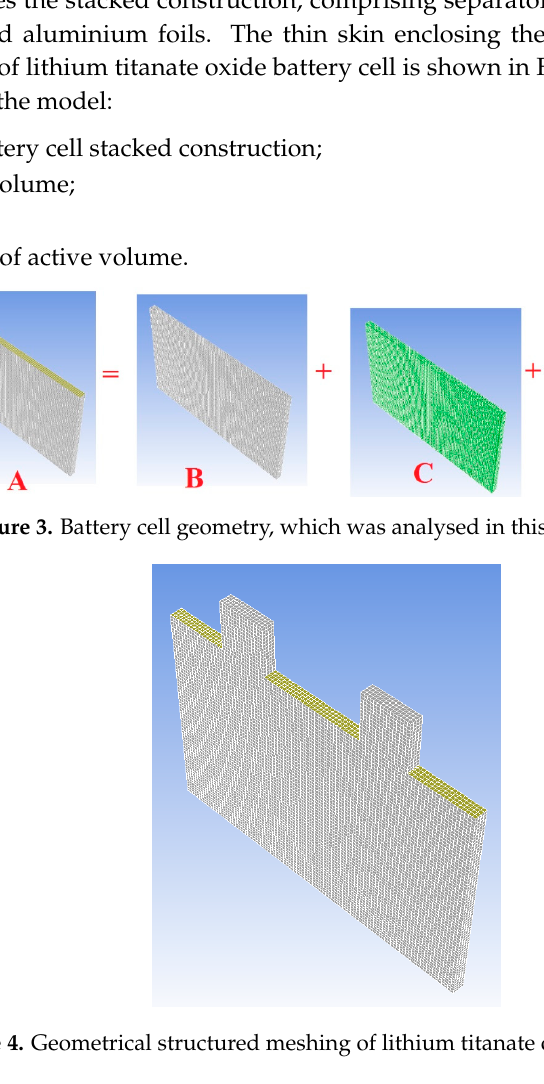
Figure 4. Geometrical structured meshing of lithium titanate oxide battery cell.